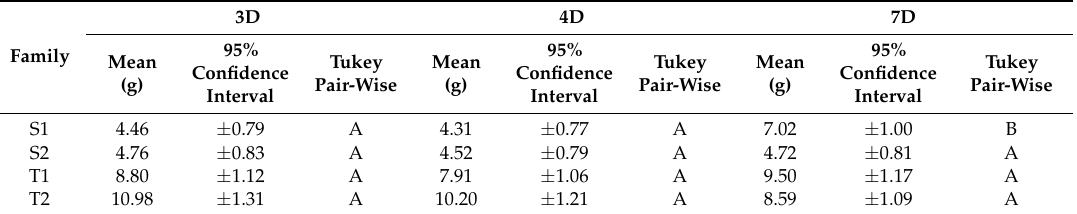
Table 6. Summary of seedling needle dry matter yield (DMY, g) by rainfall and